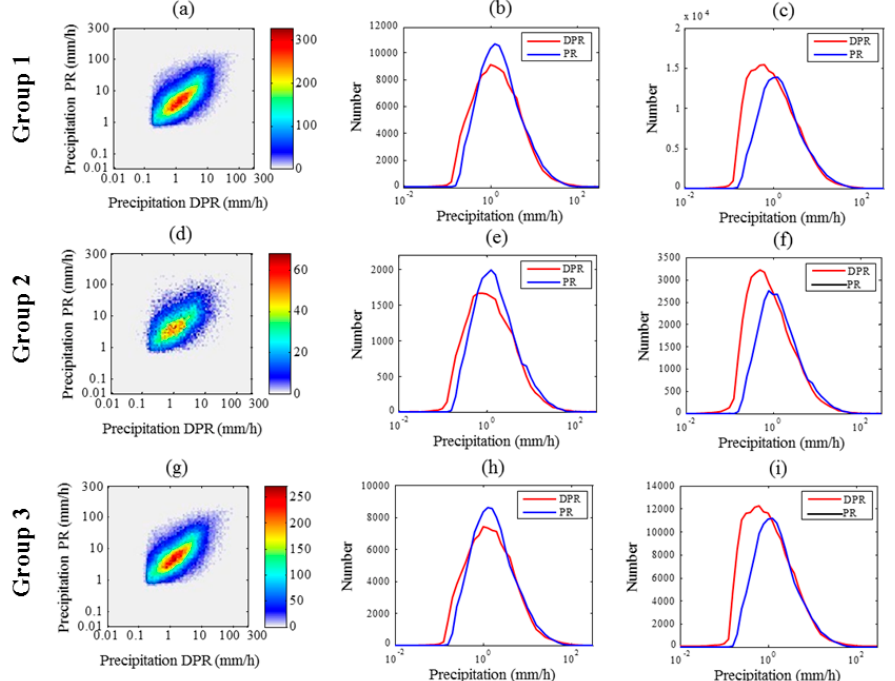
Figure 7. ( a , d , g ) Scatter plots between TRMM PR and GPM DPR based on global coincident precipitation events. The color represents event numbers for each grid corresponding to different precipitation intensities of two radars. ( b , e , h ) Precipitation frequency distributions of GPM DPR and TRMM PR based on coincident events when both radars generate positive estimates. ( c , f , i ) Precipitation frequency distributions of GPM DPR and TRMM PR based on coincident event when at least one radar generates positive estimates. The figures correspond to Groups 1–3 from top to bottom rows, respectively.